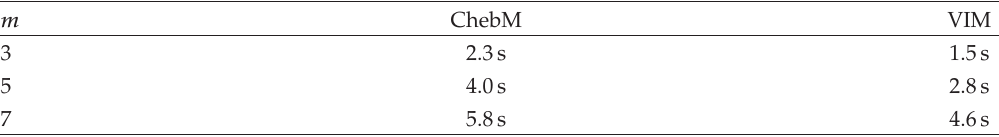
Figure 5: Show phase portrait of the system, that is, plot of x (cid:3) t (cid:4) versus x (cid:3) t − r 1 (cid:4) (cid:3) a (cid:4) and plot of x (cid:3) t − r 1 (cid:4) versus x (cid:3) t − r 2 (cid:4) (cid:3) b (cid:4) at r 1 (cid:8) 0 . 7, r 2 (cid:8) 0 . 7, and α (cid:8) 0 . 85. Table 1: The CPU time needed for the computation with each